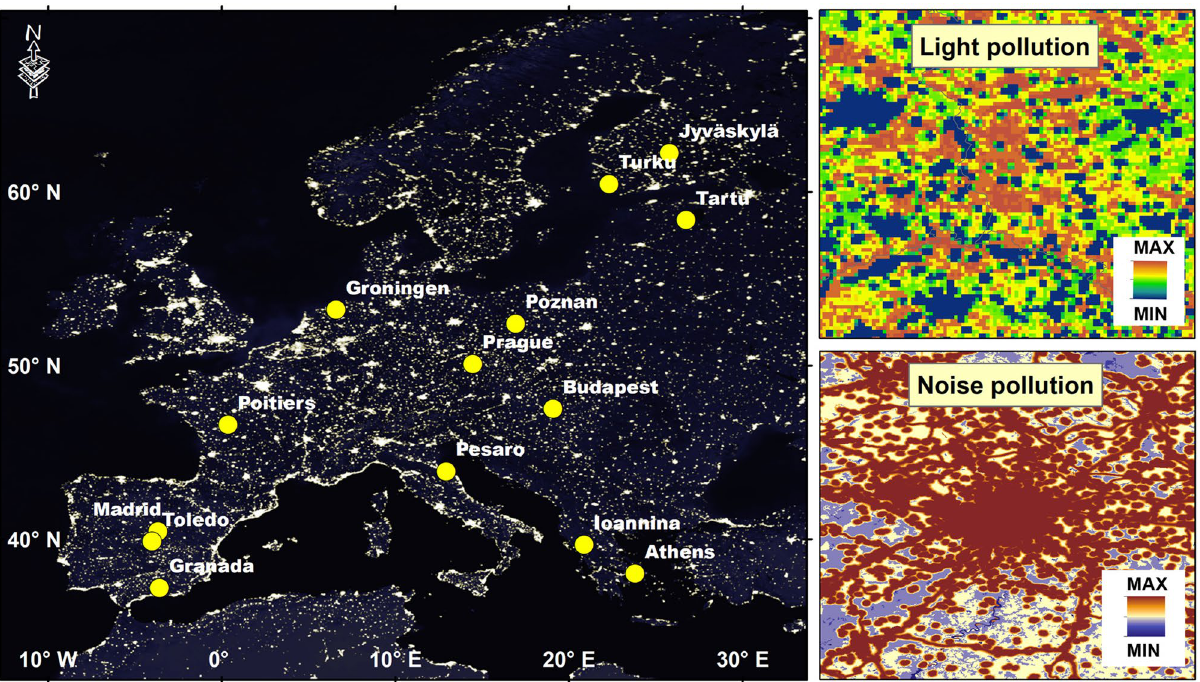
Figure 2. Fourteen European cities focused on this study and the map of artificial light at night (ALAN). The ALAN map was produced by mosaicking Defense Meteorological Satellite Program (DMSP) Operational Linescan System (OLS) satellite images (source: ESRI, NASA—Visible Earth). On the right side, two examples of mapping light and noise pollution in Prague, the Czech